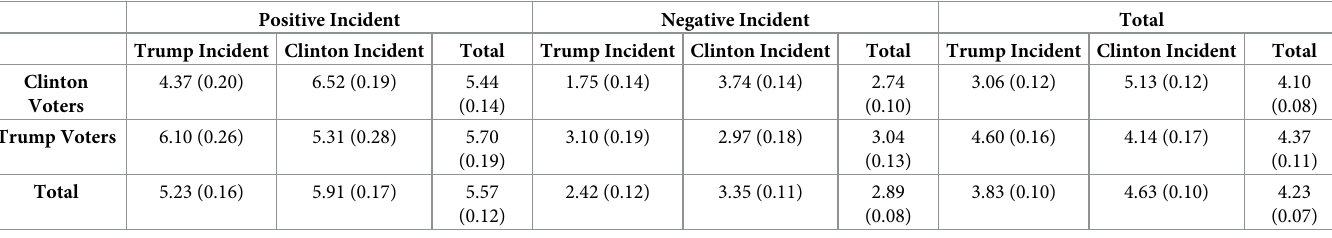
Table 1. Estimated marginal means and standard errors by cell for perceived valence of past